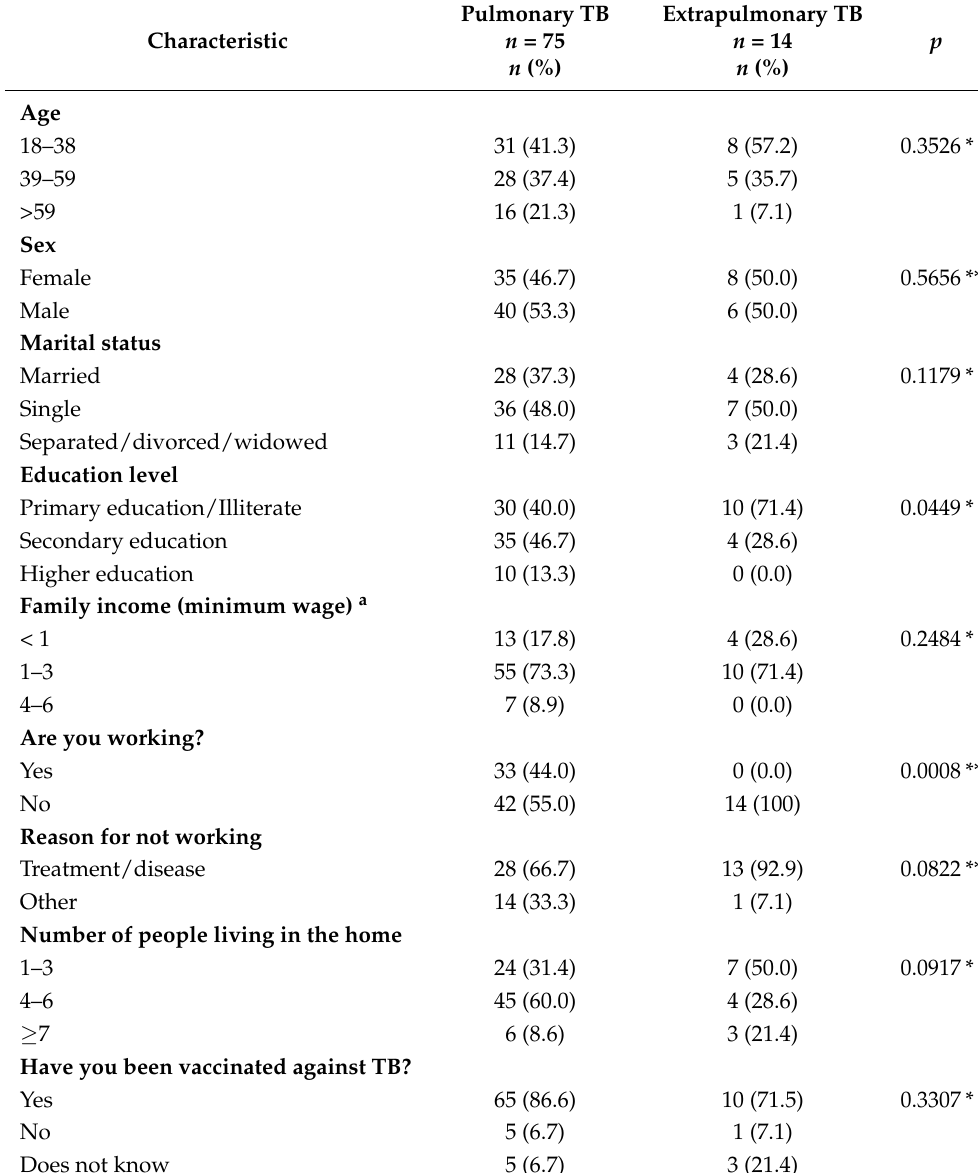
Table 2. Epidemiological characterization of patients with pulmonary TB and extrapulmonary TB.